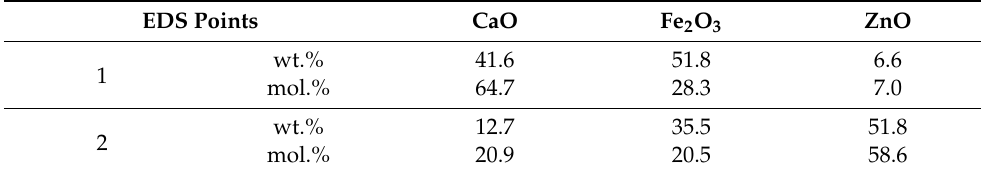
Table 3. EDS analysis of the roasted product with the roasting time of 1 h. EDS Points